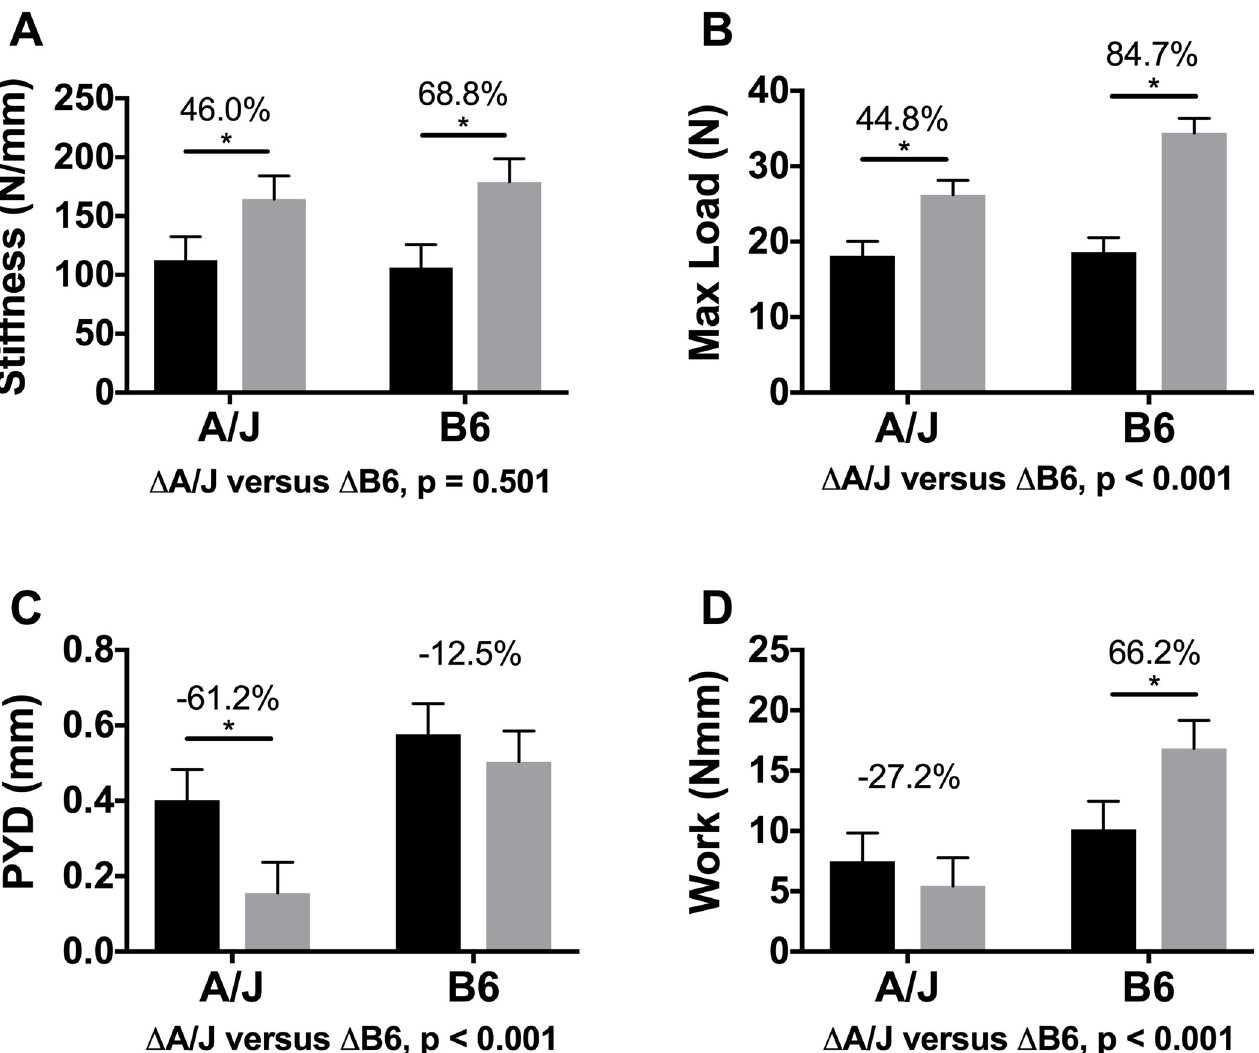
Fig 3. Four-point bending of the femurs of treated and untreated mice. Both strains of treated mice showed greater whole bone A) stiffness and B) strength compared to their respective controls. C) PYD was significantly smaller with treatment in A/J but not B6, and D) Work showed divergent outcomes, being significantly smaller in treated A/J femurs but significantly greater in treated B6 femurs compared to their respective controls. Main effects by strain and treatment as well as the interaction of strain by treatment were tested using an ANOVA. Percent changes were calculated from least square mean differences of Tukey pairwise comparisons ( p < 0.05). Black bars = Vehicle and gray bars = Scl-Ab treated.